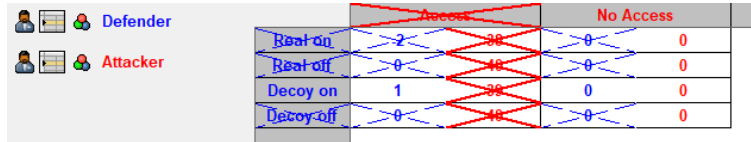
Figure 5. Results of the dominance for N 50 .